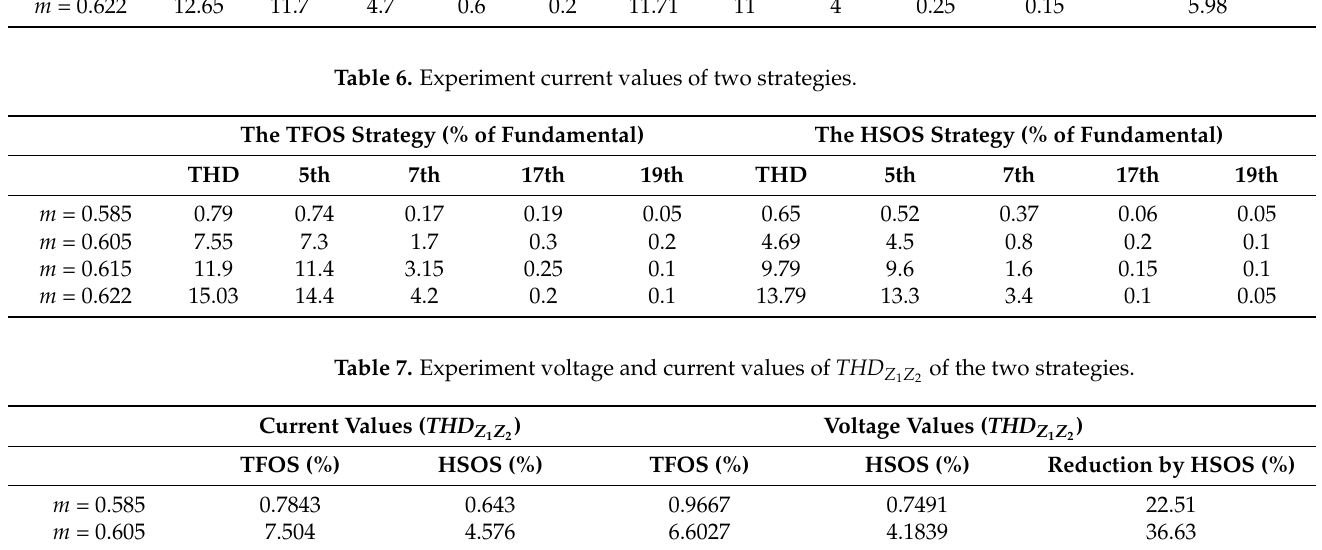
Table 5. Experiment voltage values of two strategies.